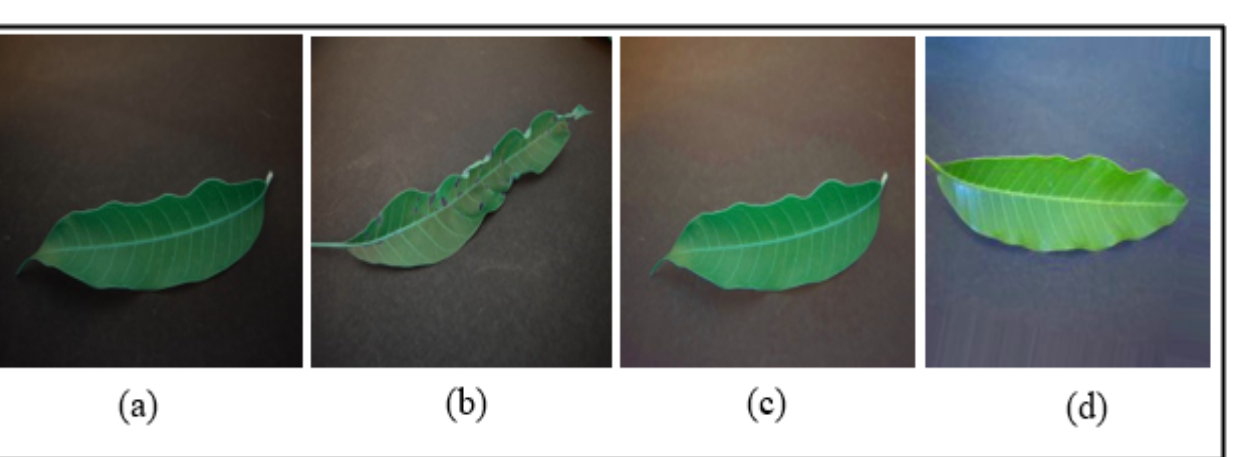
Figure 5. Steps for pre-processing and organisation of the original dataset for generation of Dataset I and Dataset II.